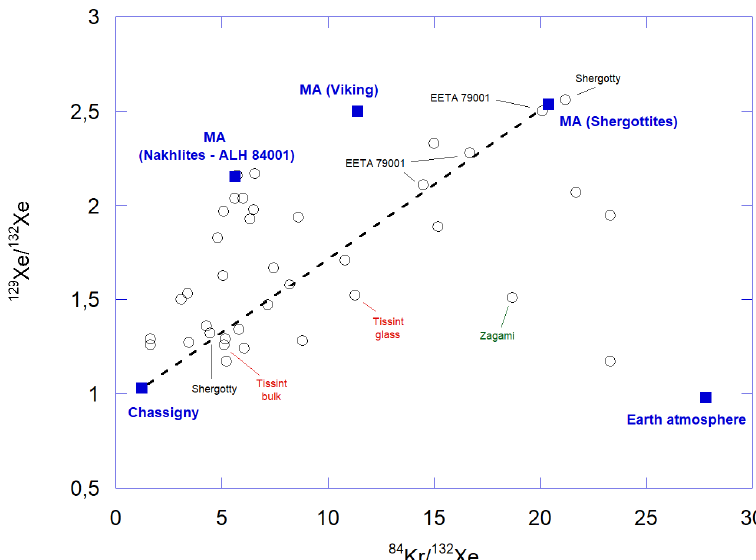
Figure 11. Plot of 129 Xe / 132 Xe vs. 84 Kr / 132 Xe in Martian meteorites, data compiled after Bogard and Garrison [98] and [47]. Martian atmosphere based on meteorites (shergottites and nakhlites) and on the Viking data [20] (MA), Martian interior (Chassigny) as well as the Earth atmosphere are indicated. Error bars are omitted for the clarity of the data. Adapted and modified from the work in [47].